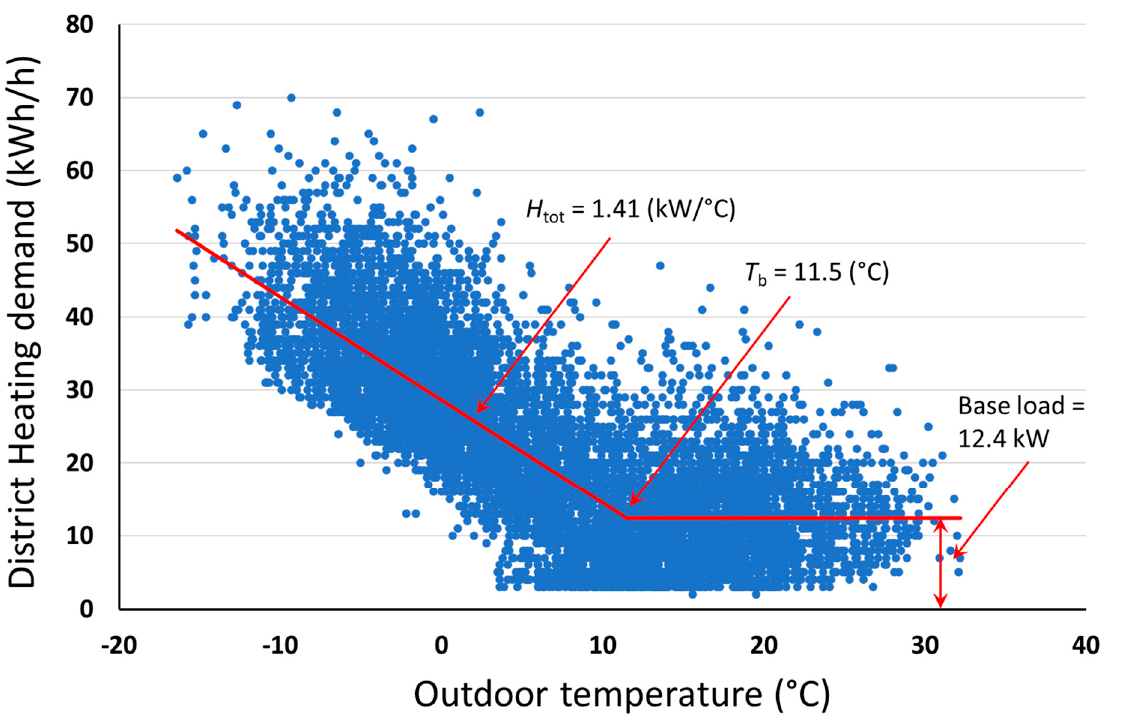
Figure 3. Energy signature diagram for the supplied district heating for space and DHW heating of the studied multifamily building. The blue points represent the daily average supplied DH in 2018.